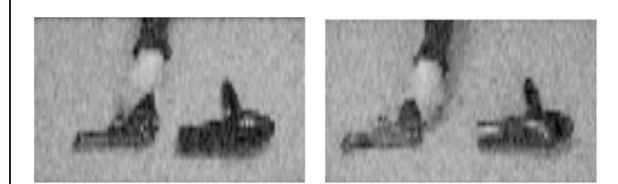
FIGURE 2 | Examples of still frames from videos depicting grasping actions with a gun or hairdryer. From Parasuraman et al. (2009).